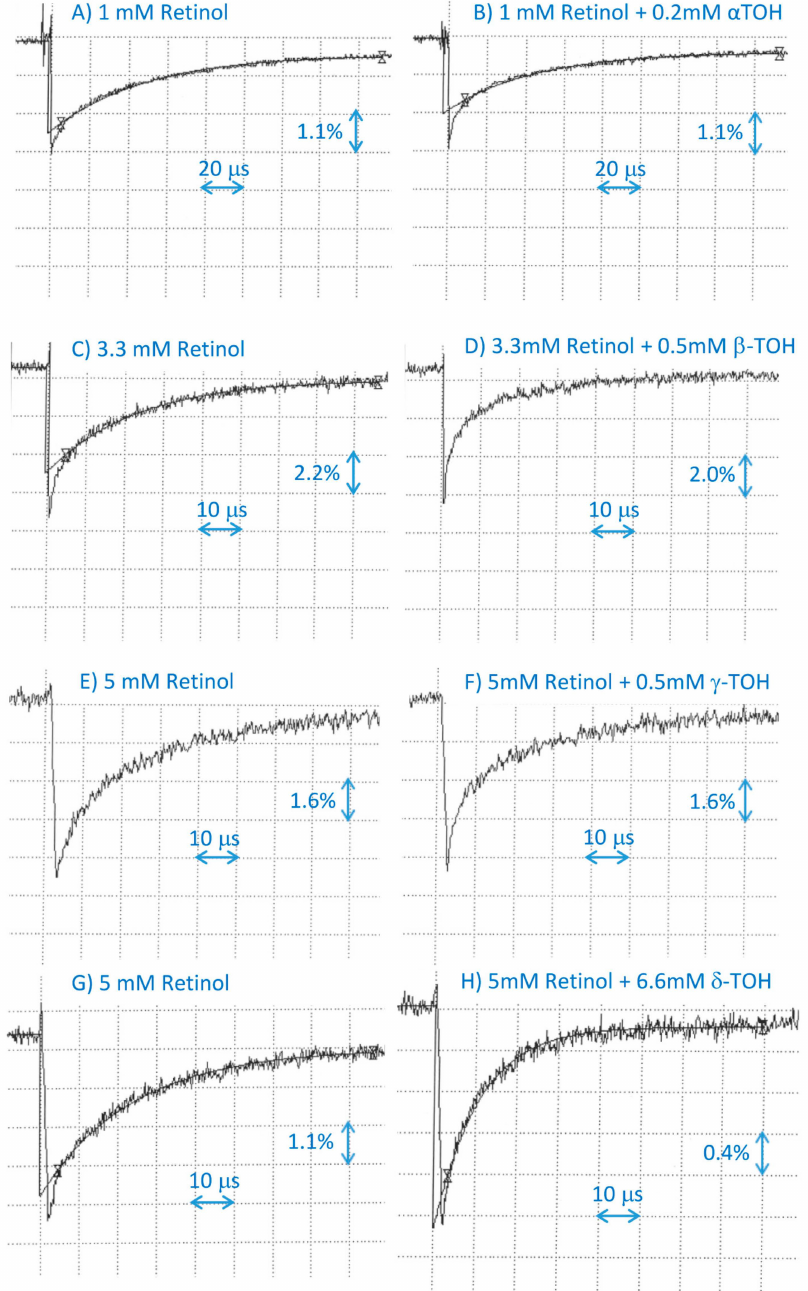
Figure 5. Representative kinetics of the formation and decay of retinol cation radicals monitored at 610 nm after pulse radiolysis of N 2 O-saturated benzene with solubilized retinol at indicated concentrations in the absence ( A , C , E , G )and presence of α -tocopherol ( α -TOH, B ), β -tocopherol ( β -TOH, D ), γ -tocopherol ( γ -TOH, F ), and δ -tocopherol ( δ -TOH, H ). Beta-tocopherol at a concentration of 0.1 mM exerted only a small e ff ect on the rate of decay of the retinol cation radicals; therefore, to explore whether they interact, the concentrations of the retinol and β -tocopherol were increased to 3.3 mM and up to 0.5 mM, respectively (Figure 5; Table 1). The rate of scavenging of the retinol cation radical by β -tocopherol was (1.6 ± 0.9) × 10 8 M Also, the e ff ect of 0.1 mM of γ -tocopherol on the rate of decay of retinol cation radicals was rather small, so the concentrations of retinol and γ -tocopherol were increased to 5 mM and 0.5